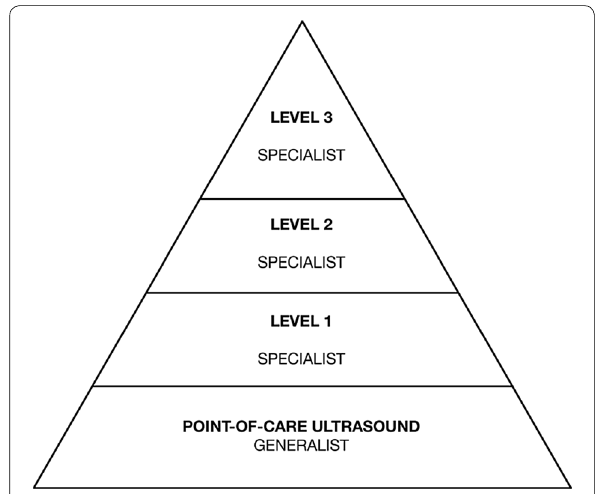
Fig. 2 The expertise pyramid. The conventional perception of ultrasound competency expressed in the expertise pyramid. The point-of-care examination is placed as the lowest level of expertise, and the pyramid visualizes how the physician can extend their expertise to advance to more sophisticated levels. The underlying assumption is that PoCUS is an inferior examination. The pyramid does not permit point-of-care ultrasound to possess strengths, such as speed, cost, and availability, which are superior to the layers above it (Adapted from Oxorn and Pearlman